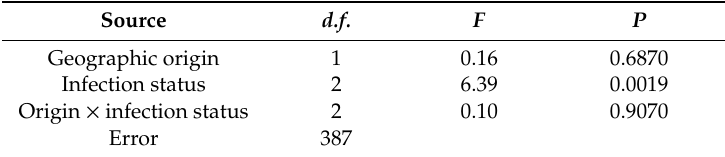
Table 4. Analysis of variance results of geographic origin, infection status, and interaction on the number of eggs laid by populations of Aedes aegypti from Brazil and Florida following oral exposure to Mayaro